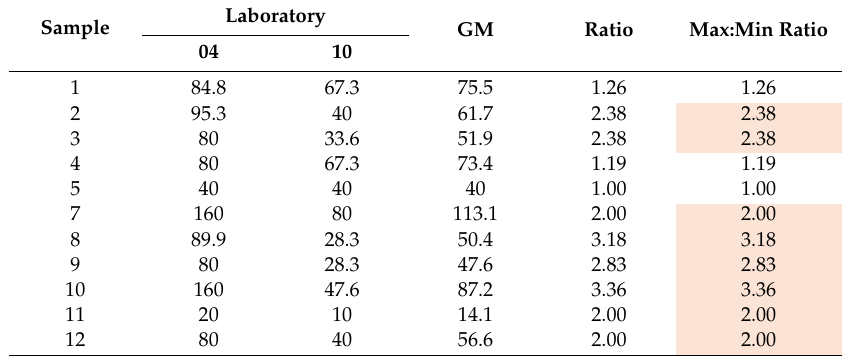
Table 4. Geometric mean endpoint readout estimates—Virus Neutralization